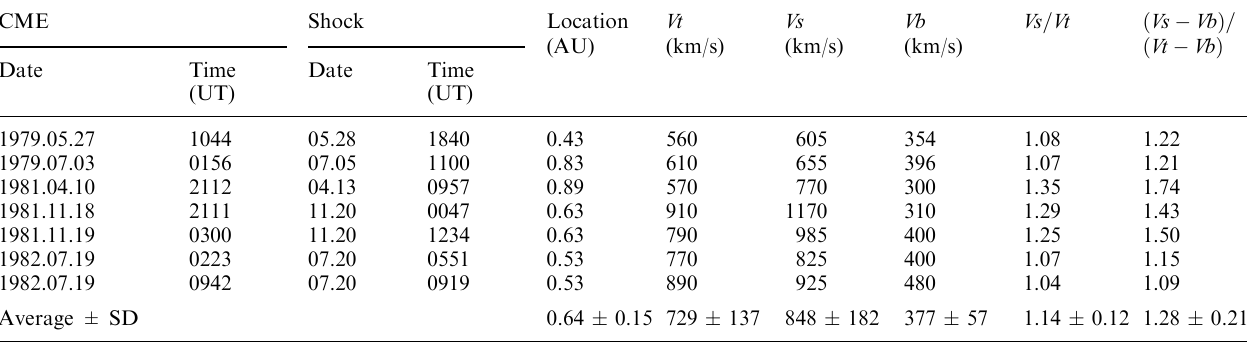
Table 5. Examples of continuously accelerating interplanetary shocks CME